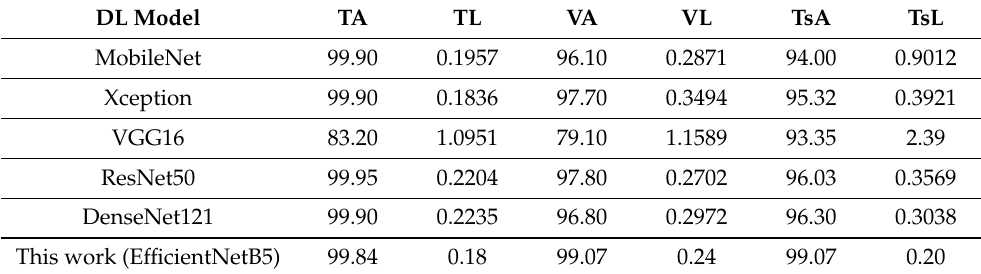
Table 2. Analysis of the suggested model in comparison to the MobileNet, Xception, VGG16, ResNet50, and DenseNet121 models. Training accuracy, training loss, validation accuracy, validation loss, test accuracy, and test loss are abbreviated as ’TA’, ’TL’, ’VA’, ’VL’, ’TsA’, and ’TsL’, respectively.